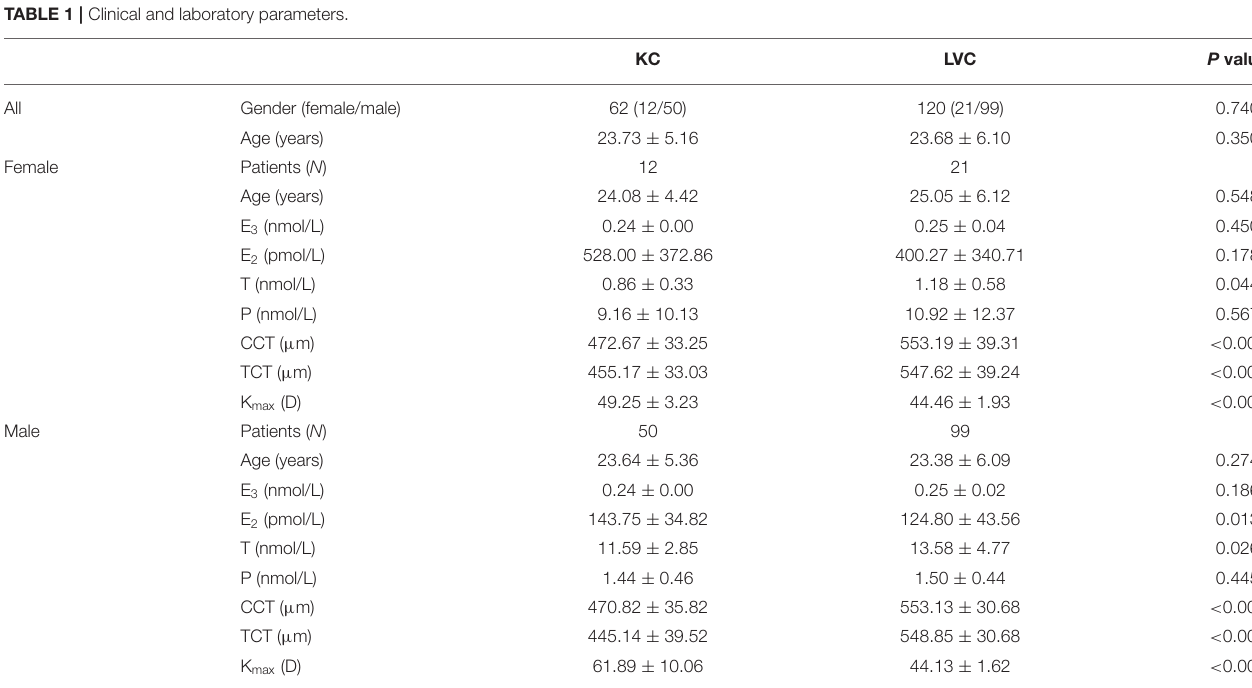
TABLE 1 | Clinical and laboratory